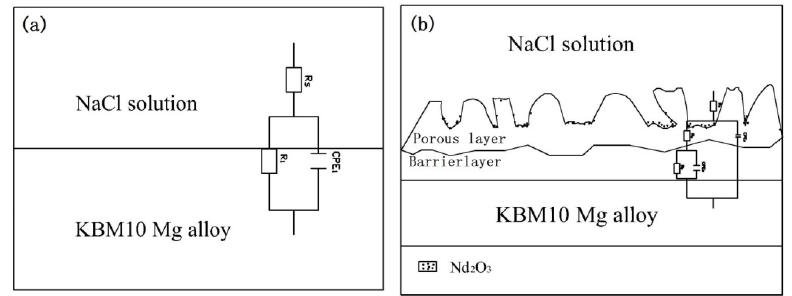
Table 4. Equivalent circuit data of coatings immersed in 3.5 wt % NaCl solution.